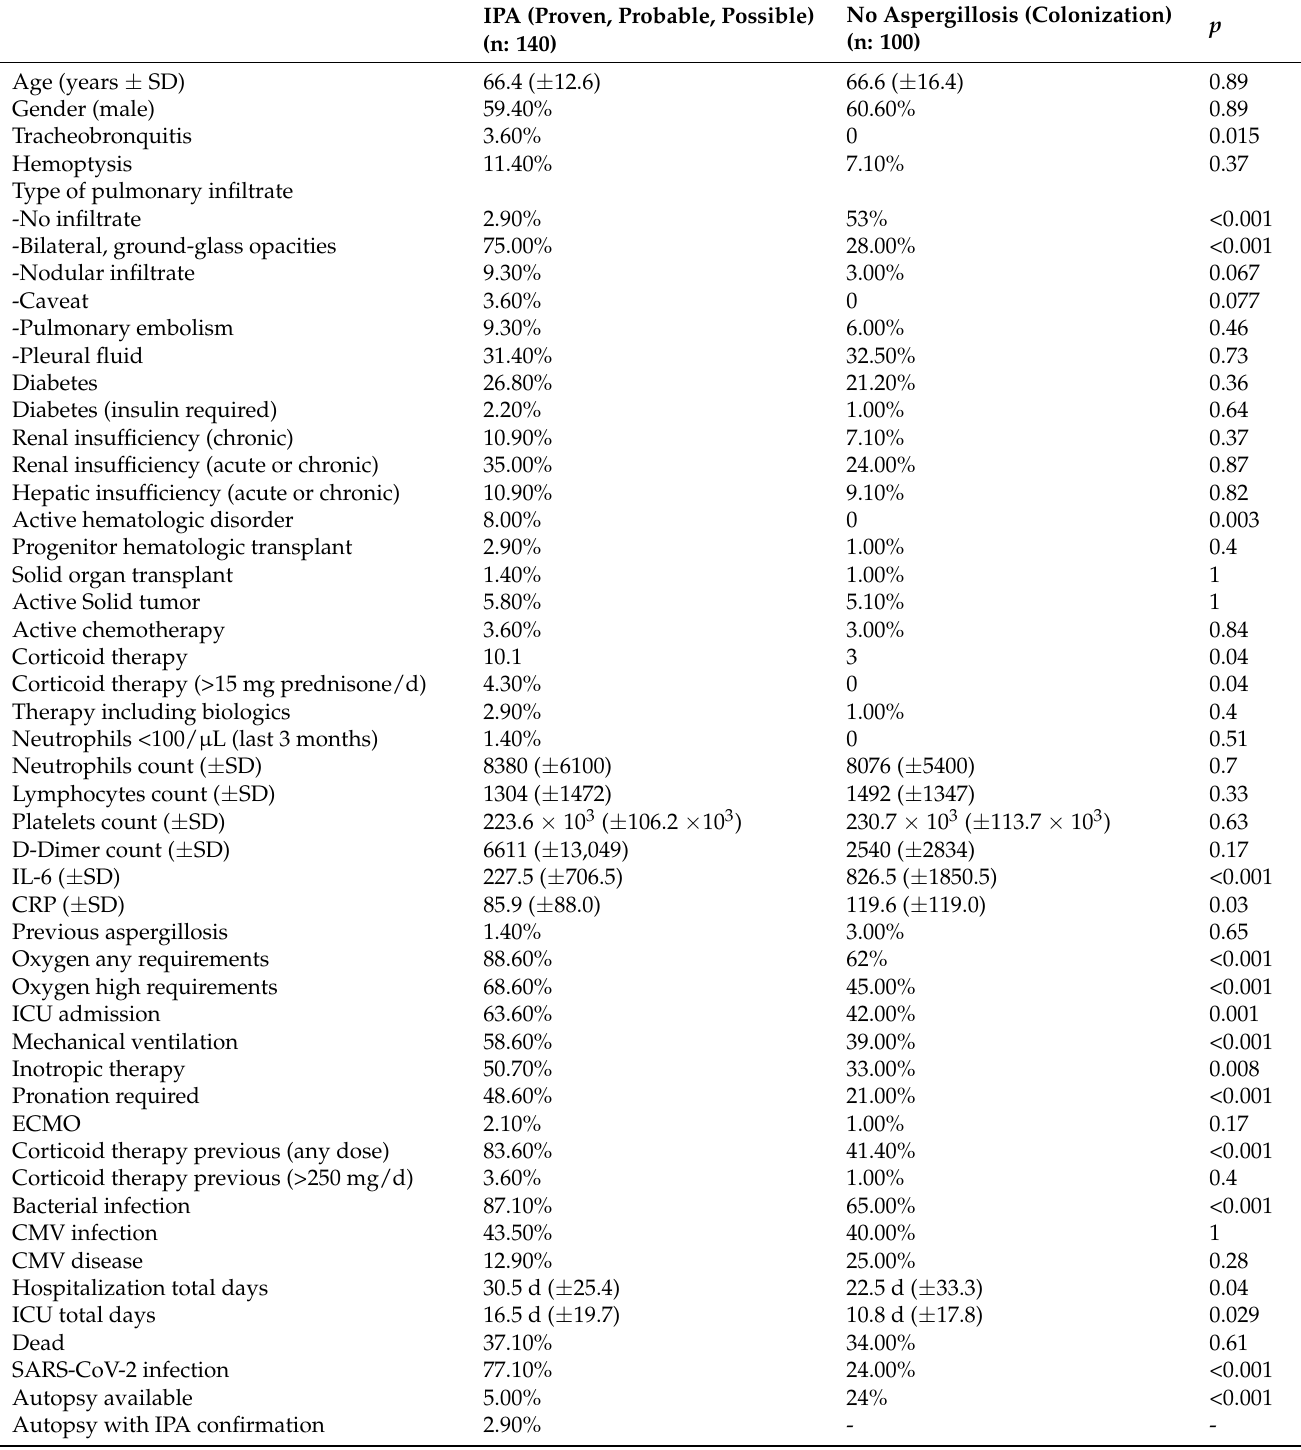
Table 1. Baseline characteristics of patients with isolation of Aspergillus in respiratory